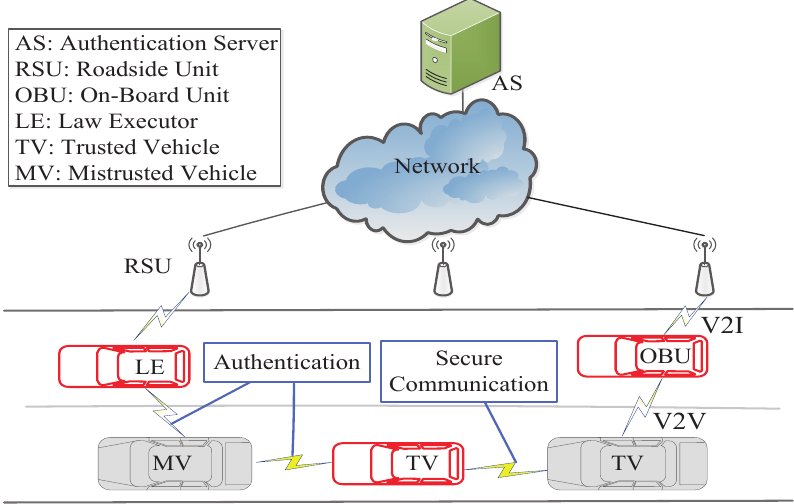
Figure 1. Structure of a vehicular ad-hoc